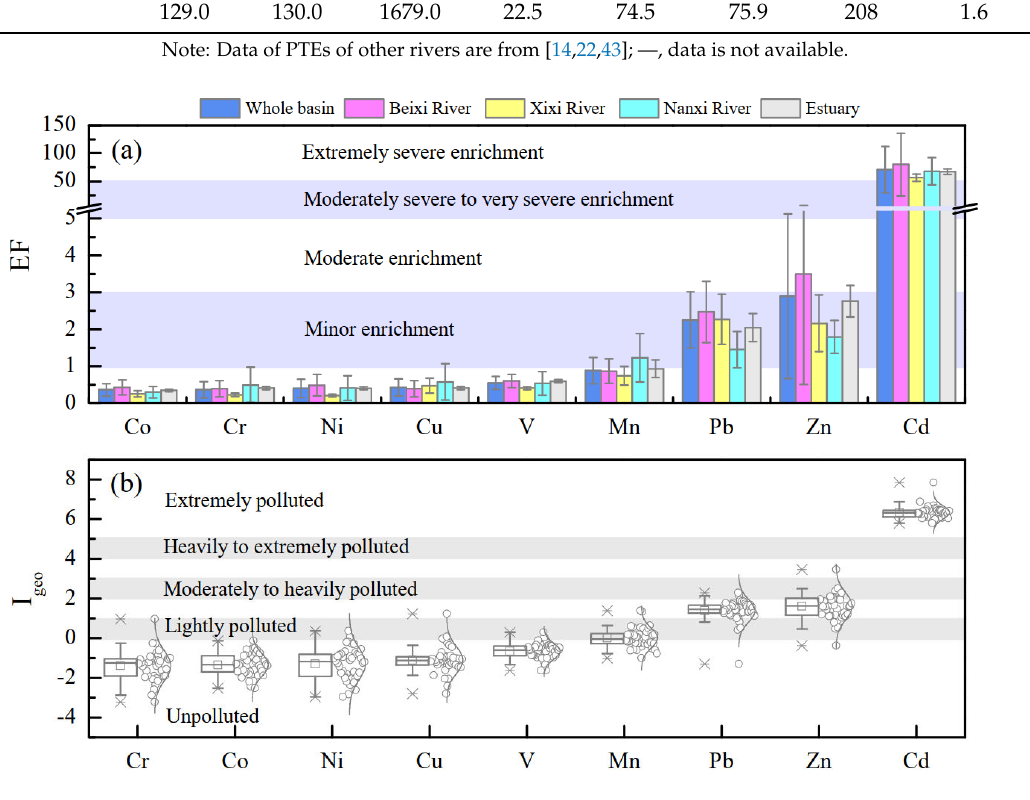
The pollution load index (PLI) of PTEs in SPM was calculated and listed in Table 3. The PLI values varied between 1.0 and 4.2 (2.1 ± 0.6) with all PLI > 1, indicating